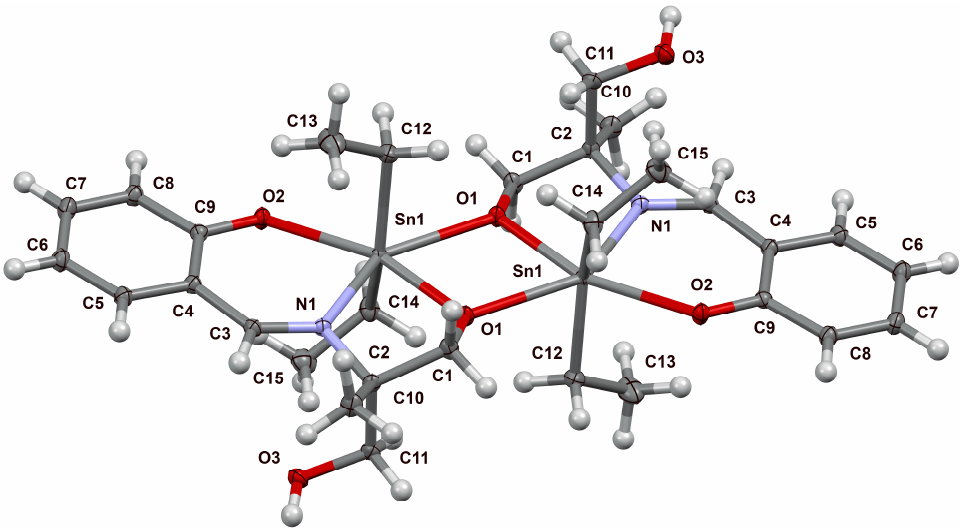
Figure 1. Molecular structure of 1 ( p = 50%). Selected bond lengths (Å) and bond angles (°): Sn(1)-O(2) 2.2657(10), Sn(1)-O’(1) 2.4090(10), Sn(1)-O(1) 2.0992(10), Sn(1)-N(1) 2.2369(11), O(2)-Sn(1)-O’(1) 133.29(3), O(1)-Sn(1)-O(2) 157.64(4), O(1)-Sn(1)-O’(1) 69.07(4), Sn(1)-O(1)-Sn’(1) 110.93(4), O(1)-Sn(1)-N(1) 76.33(4), N(1)-Sn(1)-O(2) 81.34(4), and N(1)-Sn(1)-O’(1) 145.23(4).